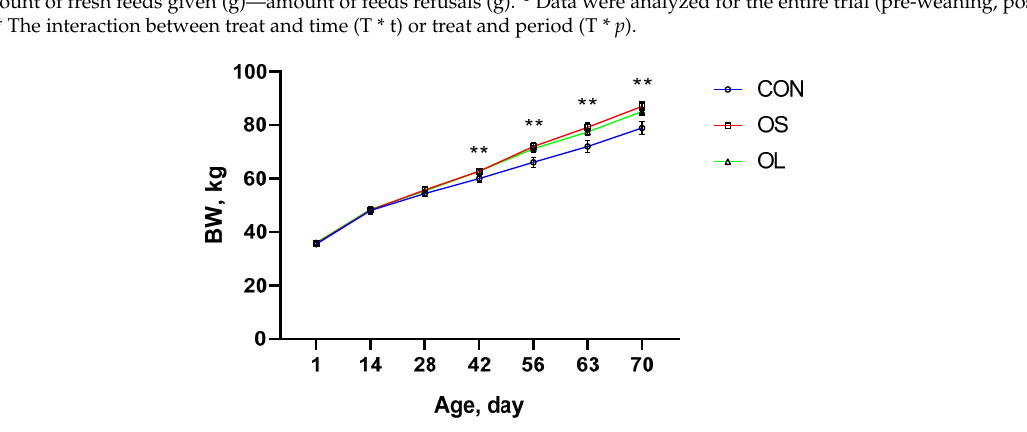
Figure 1. BW for Holstein’s calves fed a basic diet without hay (CON: empty circles; red line) and inclusion of short oat hay (OS: 3–5 cm, empty squares; green line) or inclusion of long oat hay (OL: 10–12 cm, empty triangles; blue line). Differences between CON and hay treated groups are represented by an asterisk ( p < 0.05, denoted by **).